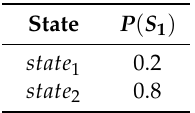
Table 3. The temporal event probability table of sensor S 1